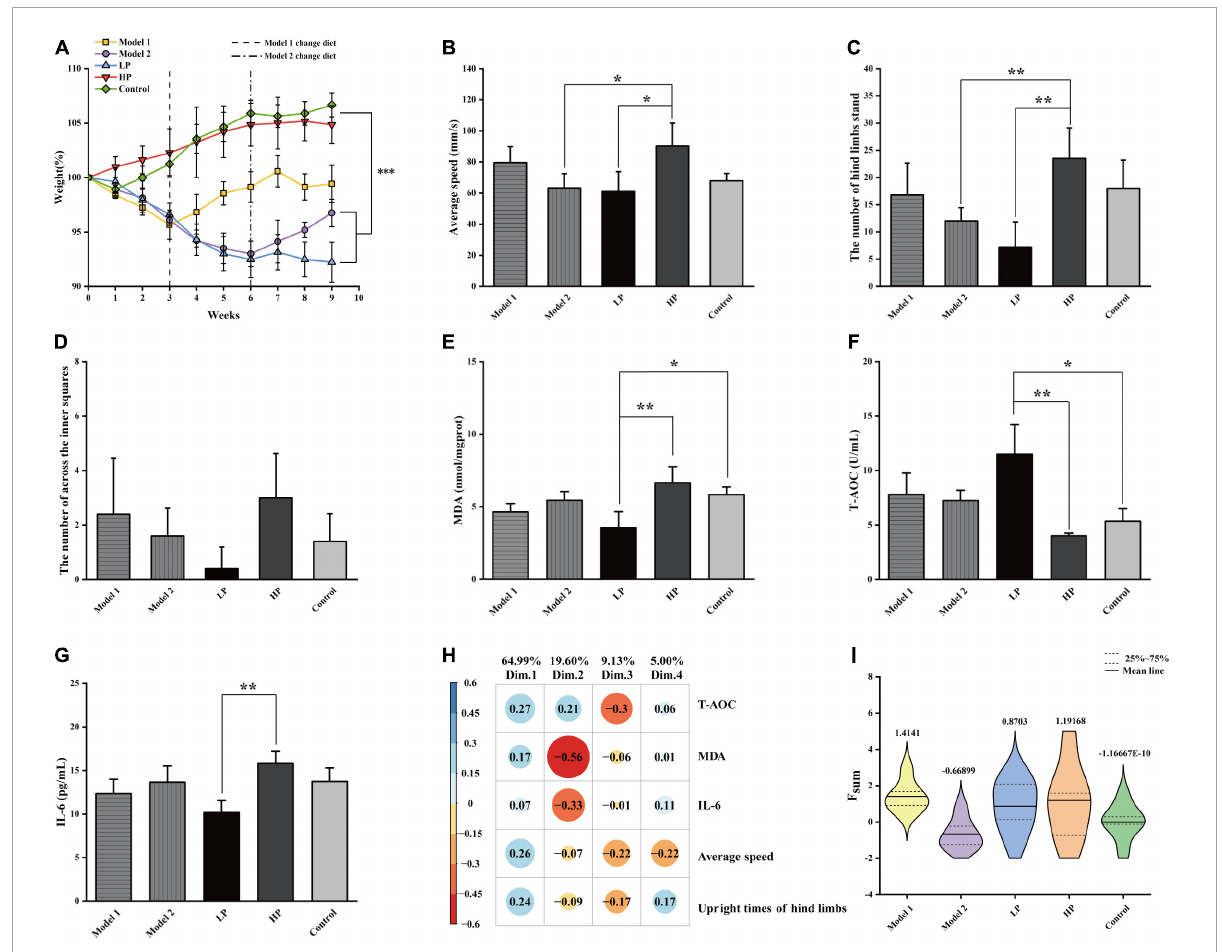
FIGURE2 Basic physiological parameters of rats and the comprehensive assessment of aging status. (A) Body weight, (B) mean movement speed of rats in the open field experiment, (C) number of upright hind limbs of rats in the open field experiment, (D) number of central region entries of rats in the open field experiment, (E) liver MDA level, (F) serum T-AOC level, and (G) serum inflammatory factor IL-6 level. All values above are expressed as mean ± SD ( n = 10), * p < 0.05, ** p < 0.01, *** p < 0.001. (H) Factor loading matrix of the principal components of the health index. (I) Violin plot of F sum scores of rats in each